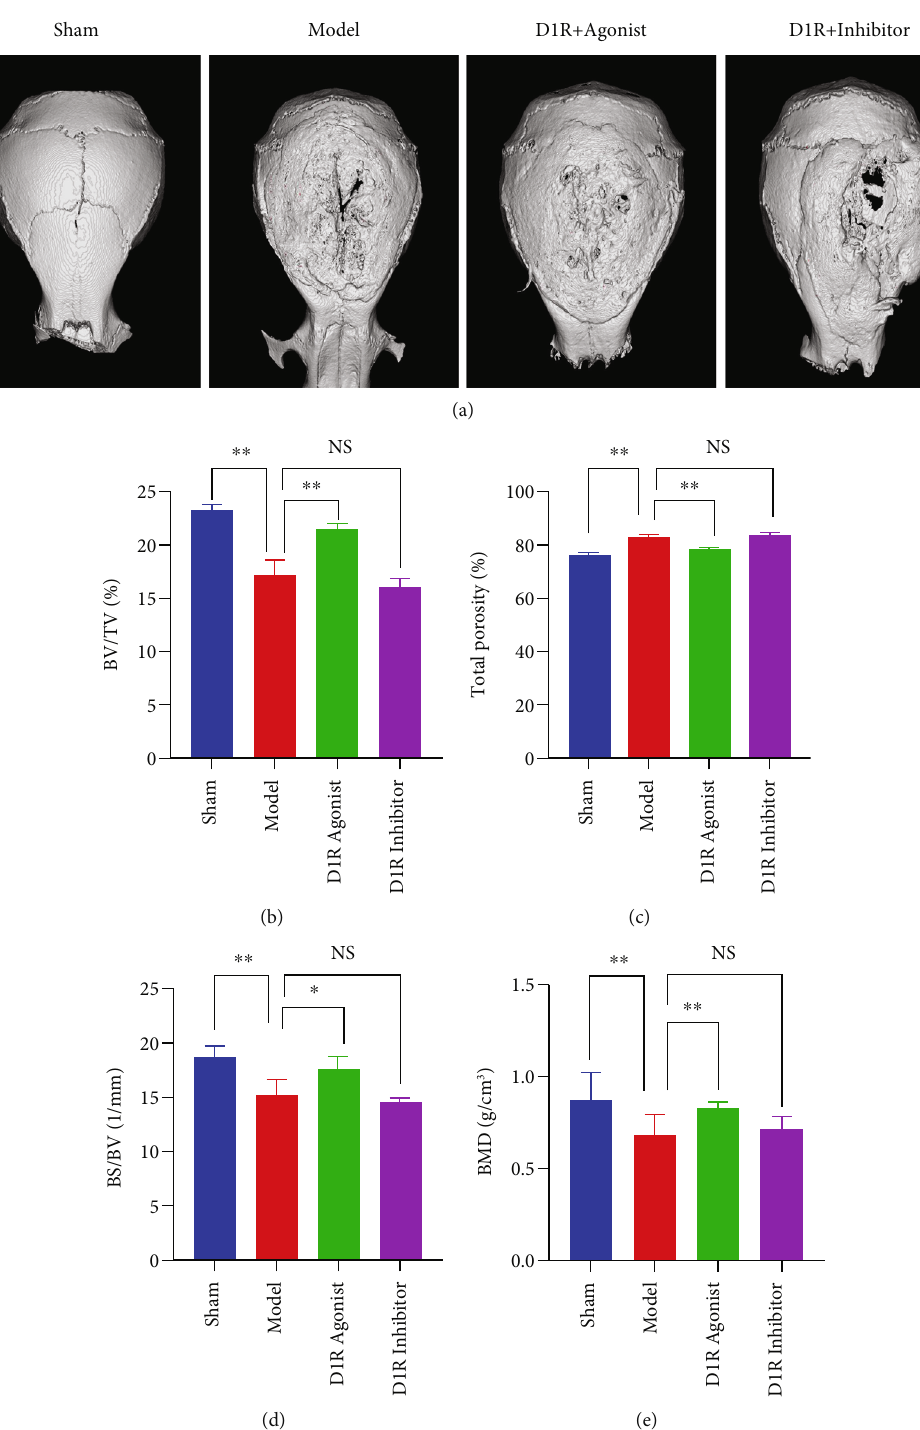
Figure 6: D1R activation alleviates titanium particle-induced osteolysis in vivo . (a) Representative 3D μ CT images of the mouse skull in the sham group, model group, D1R agonist group, and D1R inhibitor group. (b – e) Bone mineral density (BMD, in g/mm 3 ) and comparative analysis of bone structural parameters, such as the ratio of bone volume to total volume (BV/TV, in %), ratio of bone surface to bone volume (BS/BV, in 1/mm), and ratio of bone surface to total volume (BS/TV, in 1/mm). Note: n = 5 per group; ∗∗ P < 0 : 01 vs. the model